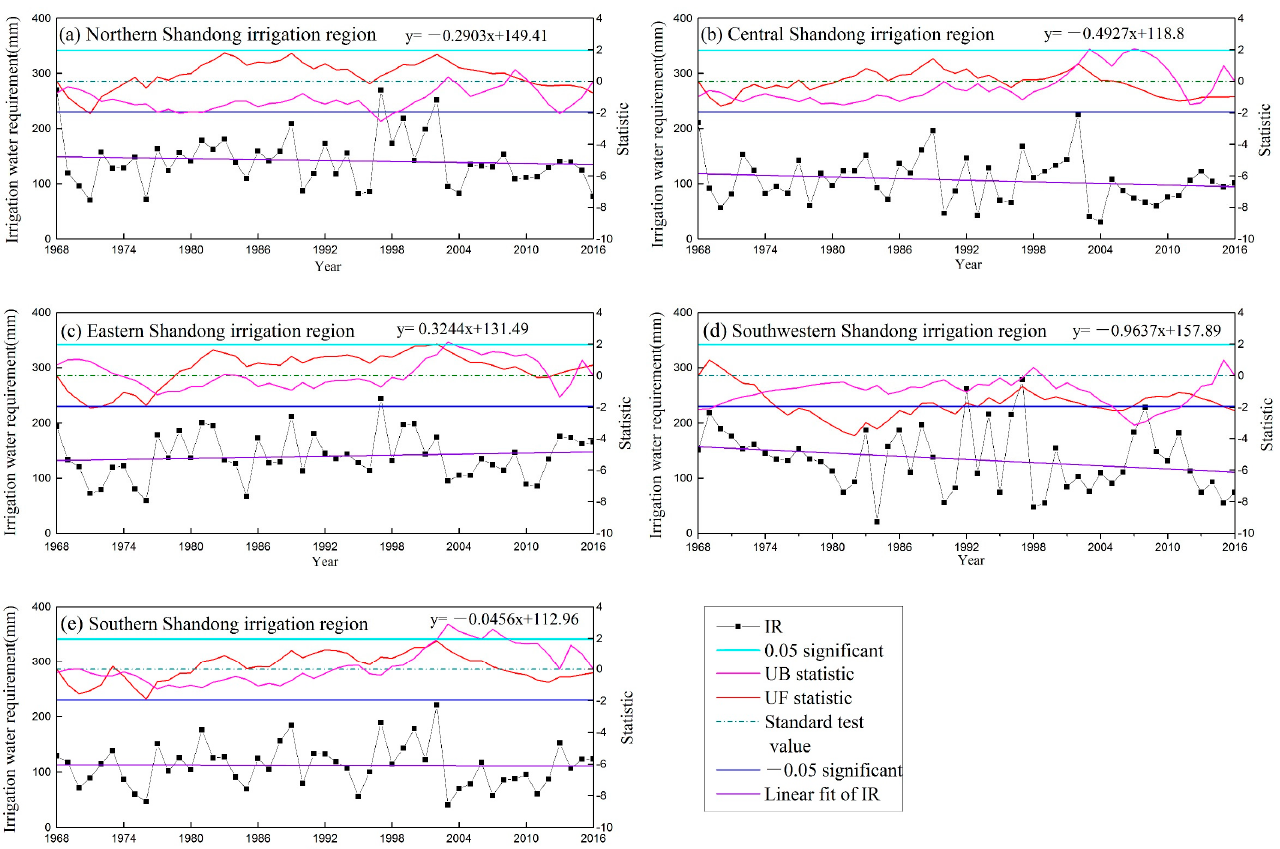
Figure 2. Variation trends of summer maize irrigation water requirements in different irrigation regions over the past 49 years. Note: ( a – e ) show the variation trends of summer maize irrigation water requirements in the northern Shandong irrigation region, central Shandong irrigation region, eastern Shandong irrigation region, southwestern Shandong irrigation region, and southern Shandong irrigation region, respectively.